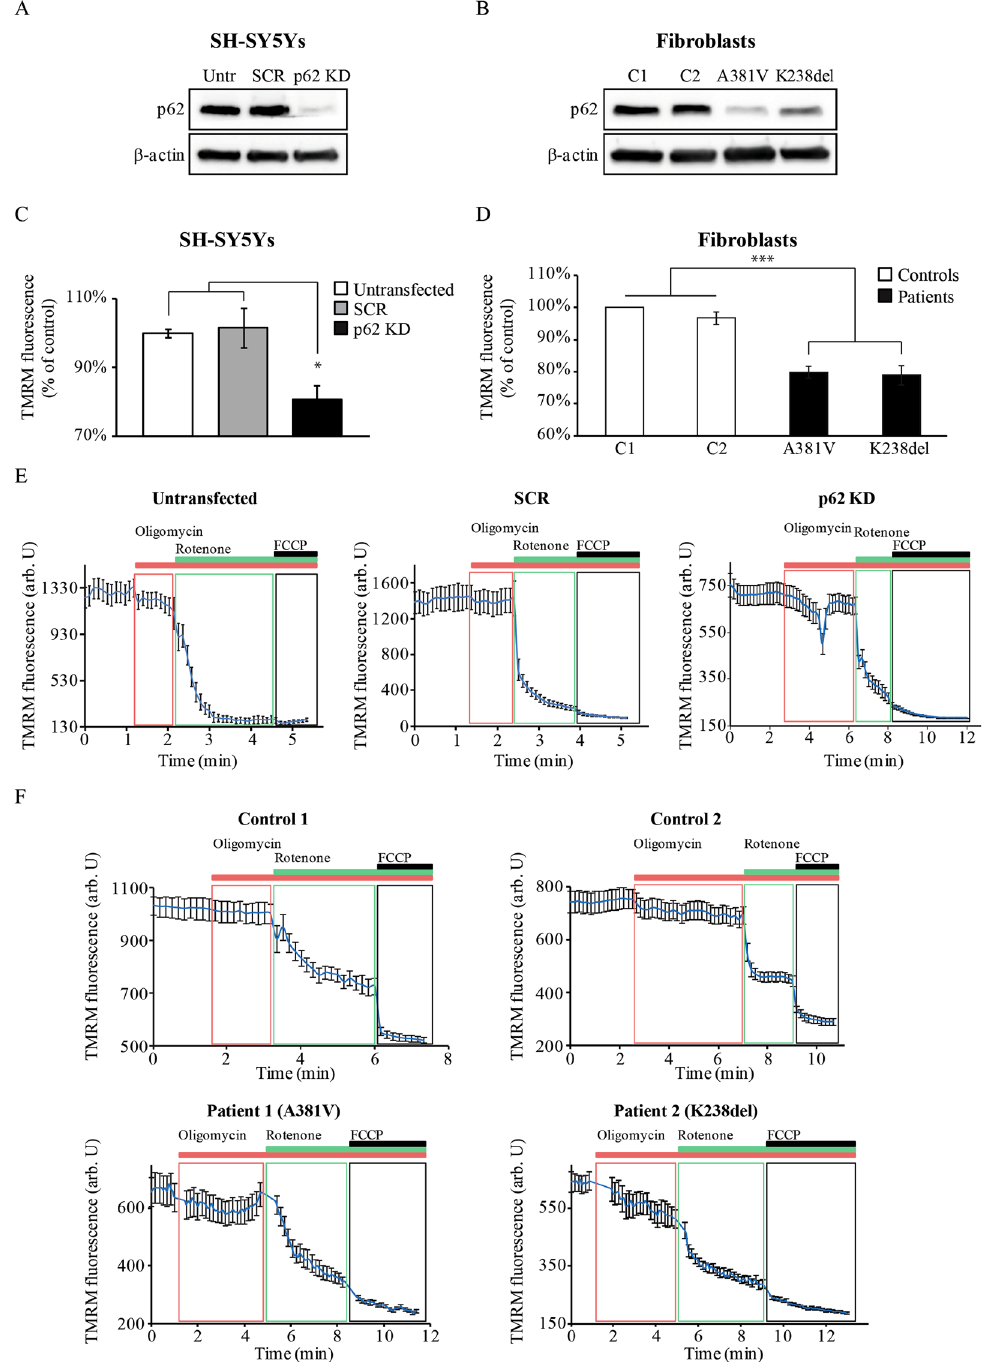
Figure 1. p62 deficiency induces mitochondrial depolarisation. ( A,B ) Immunoblotting showing the p62 protein levels corresponding to whole cell lysates from untransfected (Untr) and transiently transfected (either with SCR or p62 siRNA) SH-SY5Y cells ( A ) or fibroblasts from patients carrying p62 mutations and aged- matched controls C1 and C2 ( B ). In both A and B, β -actin was used as loading control. ( C,D ) Mitochondrial membrane potential ( ΔΨ m ) was estimated by live cell imaging in untransfected, scramble siRNA KD (SCR) and p62 KD SH-SY5Y cells ( C ) and in fibroblasts from patients carrying A381V and K238del pathogenic mutations in p62 compared to fibroblasts from two healthy donors (C1, C2) ( D ) using TMRM in a redistribution mode (40 nM). Data were normalised to control SCR cells ( C ) and control fibroblasts ( D ) and are represented as mean ± SEM from at least three independent experiments. ( E,F ) Representative TMRM traces from untransfected, SCR and p62 KD SH-SY5Y cells ( E ) and fibroblasts from control donors ( F, upper panels ) and fibroblasts from patients carrying the p62 pathogenic mutations mentioned above ( F, bottom panels ). The charts show responses to oligomycin (2 μ g/mL), rotenone (5 μ M) and FCCP (1 μ M). In all cases * indicates p < 0.05 and *** indicates p < 0.001 compared with the values of control